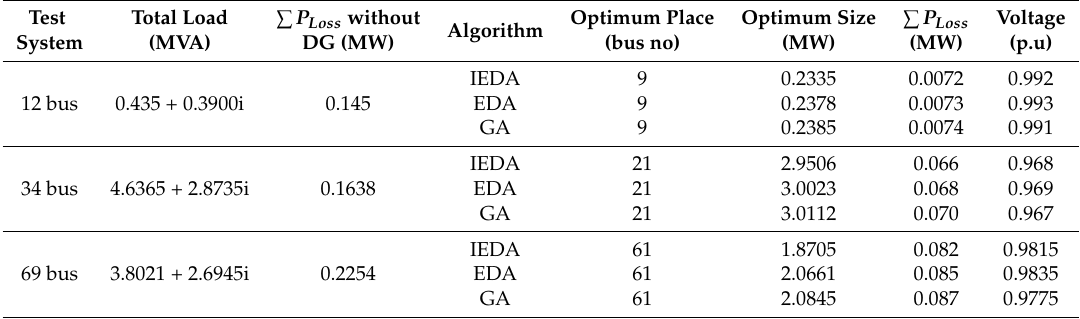
Table 2. Test results of various bus radial distribution systems under different algorithms.